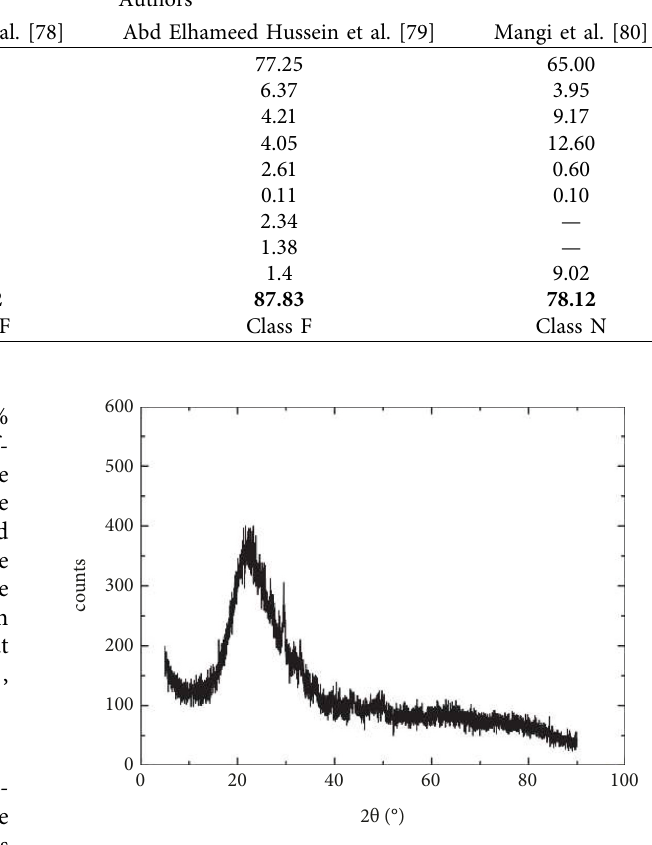
Figure 1: XRD pattern of bamboo leaf ash